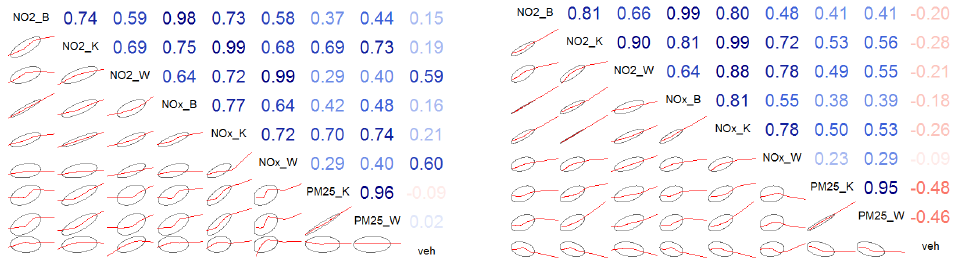
Figure 2. Spearman correlation coefficients between pollution concentrations and traffic flow for reference period 2016–2019 ( left side ) and analyzed period 2020 ( right side ); B, K—background stations, W—traffic station.